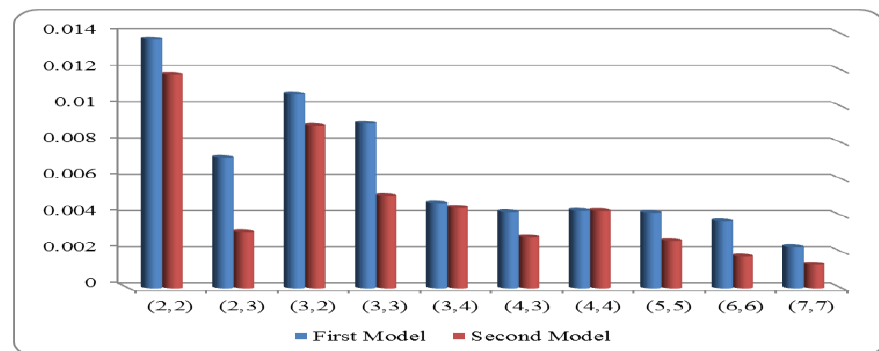
ˆ R and ˆ R for both models at R = 0.608. 1 2